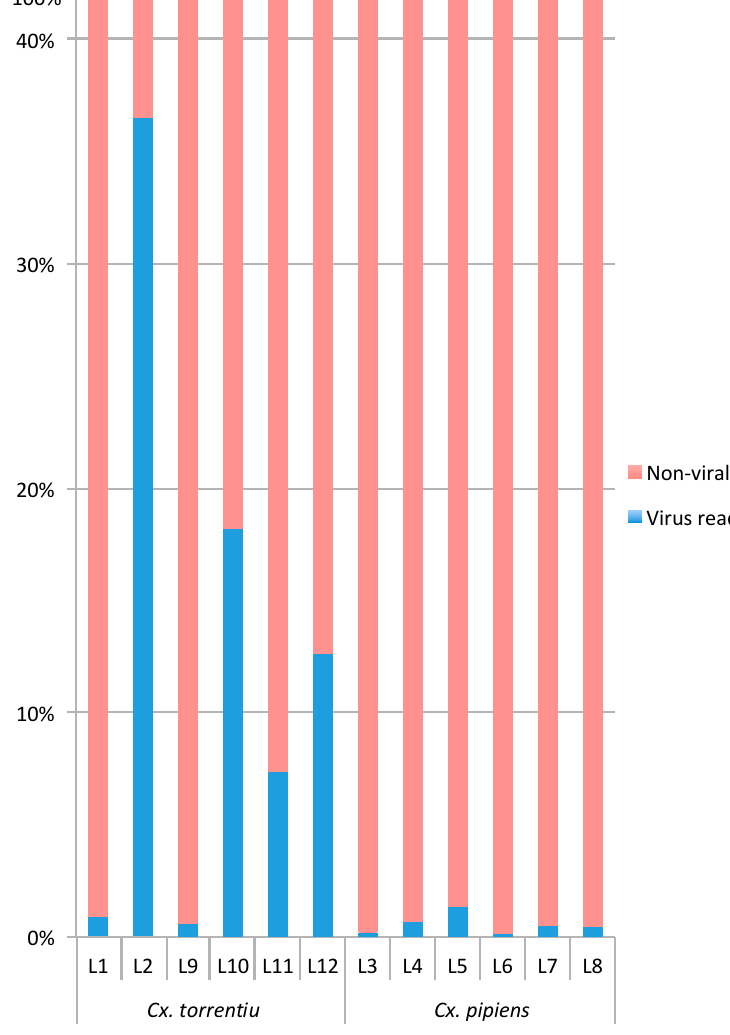
Figure 1. Estimation of virome composition in comparison to host (non-viral) content in each library.